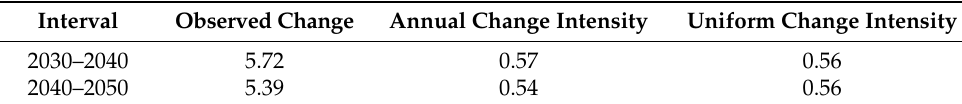
Figure 14. Transition to Water. Table 24 and Figure 15 represent the expected change intensity during 2030–2050.